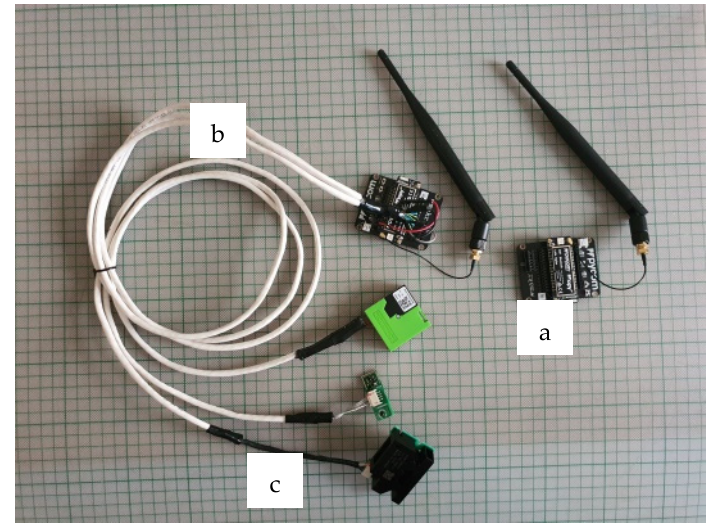
Figure 4. Scheme of the experimental setup of the LoRa sensors network based on a LoPy4 LPWAN gateway with a Pymark expansion board and the LoRa antenna mounted ( a ), LoPy4 node inserted in Pymark expansion board ( b ) and Air Quality sensors connected with LoRa node ( c ).